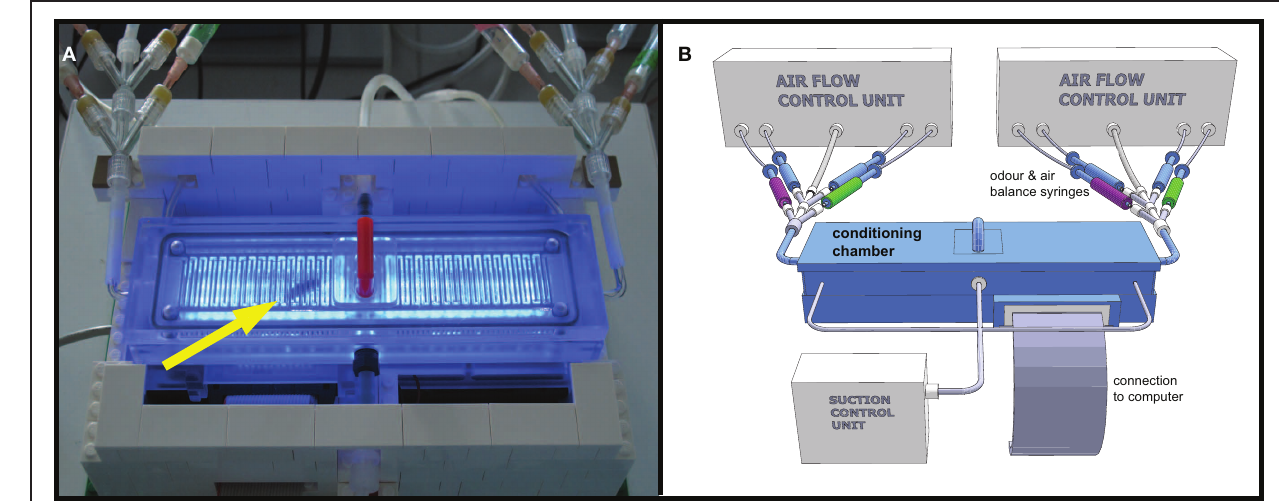
suction, while the tube in the centre of the front shows a CO 2 connection used for anesthesia during extraction of bee. (B) Schematic 3D model drawing of the APIS setup. The conditioning chamber consists of Makrolon (cid:2) and is connected to a computer, controlling both stimulus administration via the odor syringes (green and magenta for the two odors, respectively, and blue for clean air) as well as recording the movements and actions of the bee inside the chamber. Influx and efflux of air into/out of the chamber were controlled throughout the